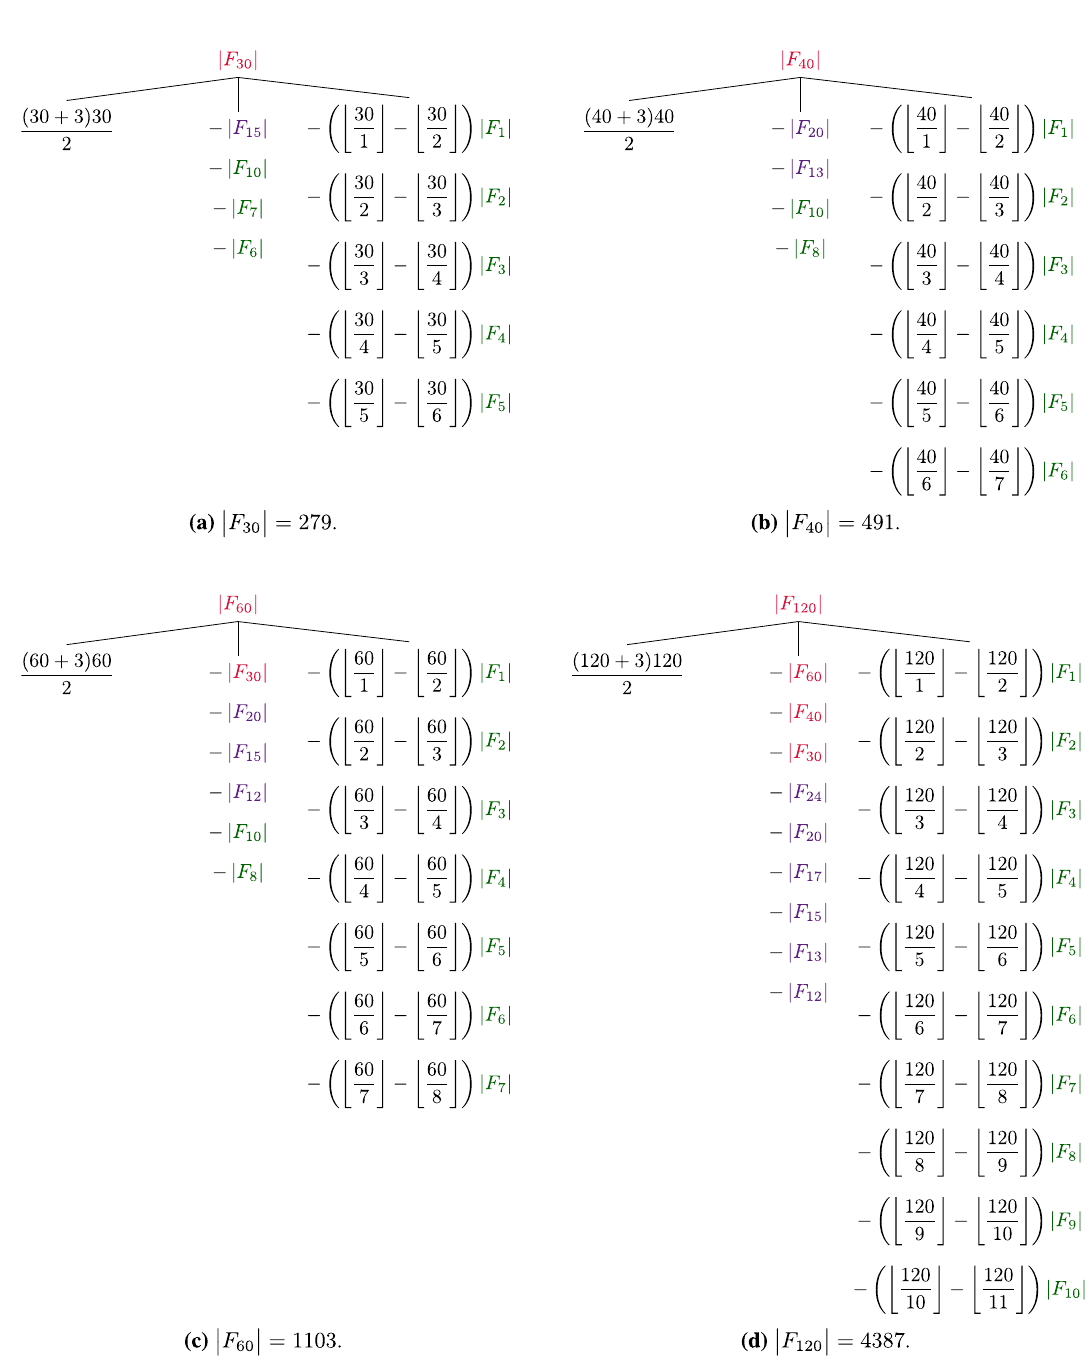
Figure 7. Visualization of the last stage of algorithm E in which the helper function is used to compute F 40 F 60 F 120 , , and when the algorithm is called with n | | | | | | different methods for computing intermediate results and storing them in the lookup table. That is, green terms are set on line 13. Purple terms are processed on line 31. Finally, the red terms are computed on line 35, during the call to